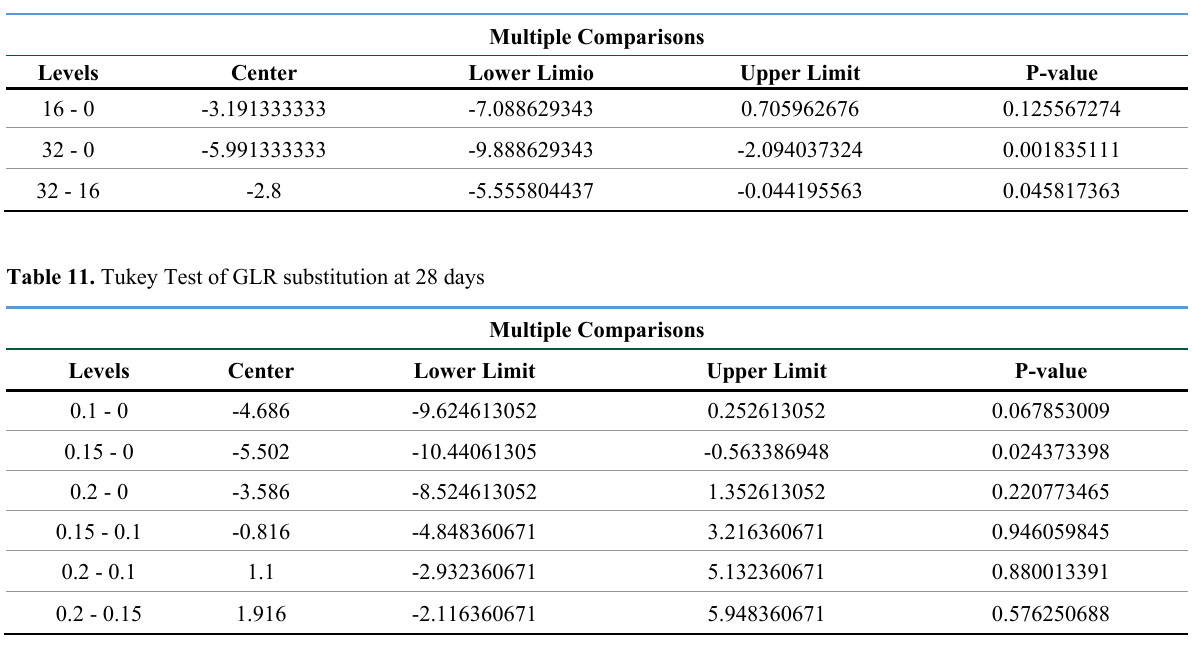
Table 10. Tukey Test of GLR milling time at 28 days